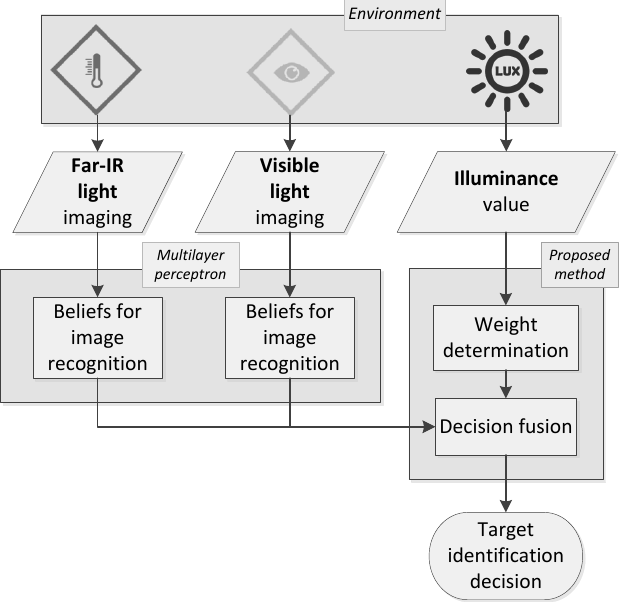
Fig. 1. The method structure for target